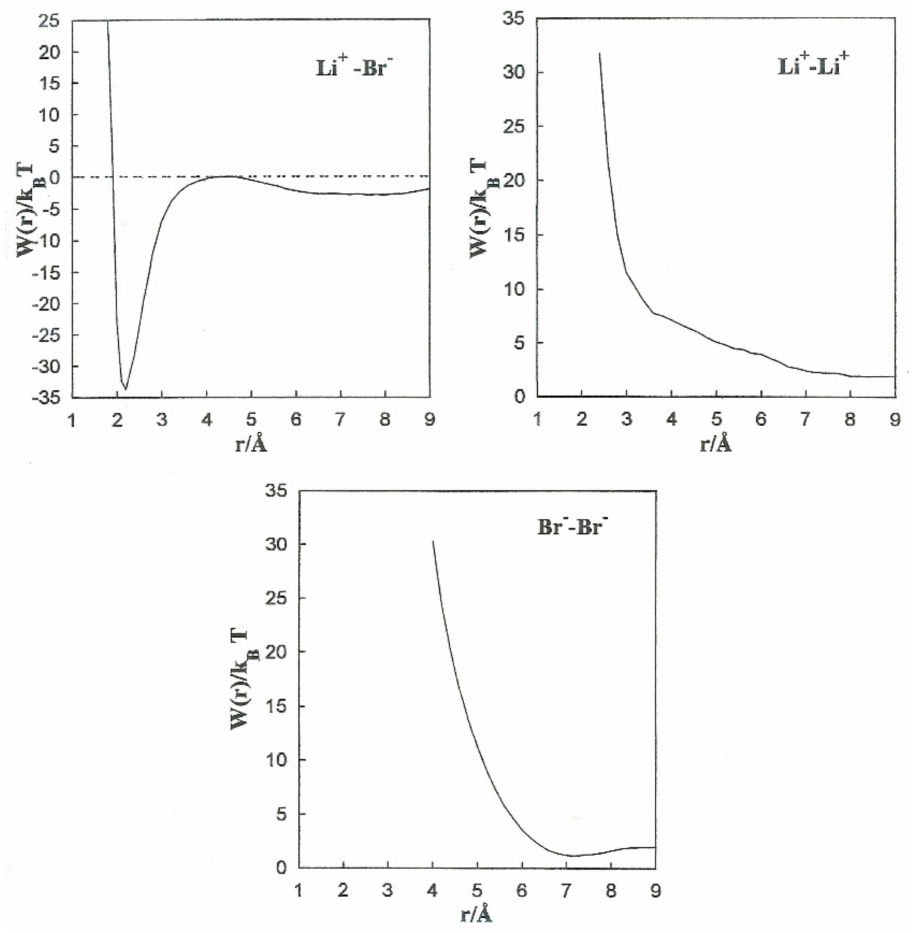
Figure 5. Mean force potentials for the various ion pairs. The stability of the CIP and SSIP regions is indicated by the association constants